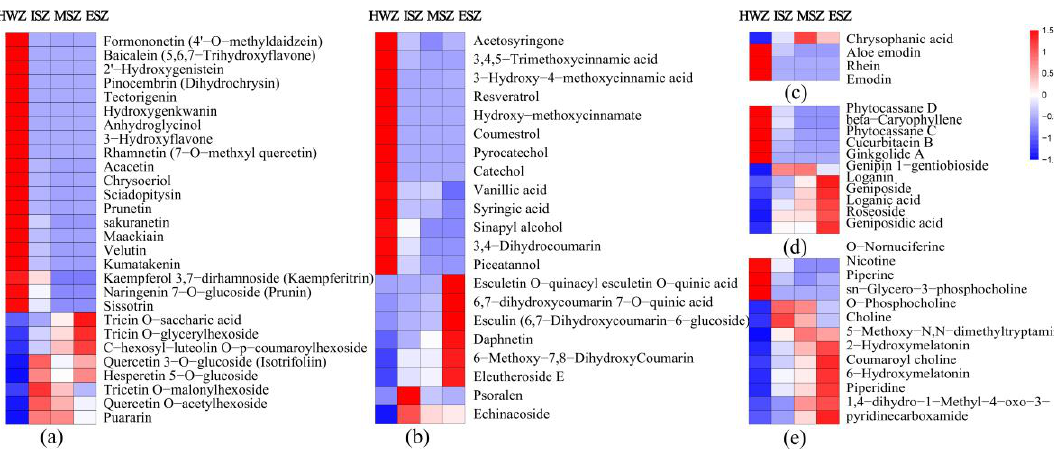
Figure 6. The differential secondary metabolites analysis between ISZ, MSZ, ESZ, and HWZ. ( a ) flavonoids, ( b ) phenylpropanoids, ( c ) quinones, ( d ) terpenes, and ( e ) alkaloids. Ratios of fold changes are given by shades of red or blue colors. Data represent mean values of three biological replicates for each sample.